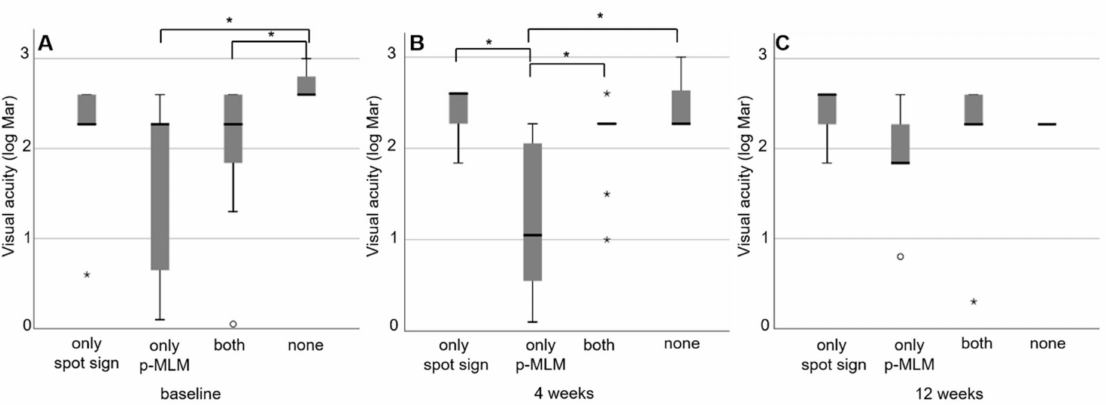
Figure 5. Box plot of visual acuity grouped by different factors (spot sign, p-MLM sign, both and none) at ( A ) visit 1; ( B ) visit 2 and ( C ) visit 3; * p < 0.05.